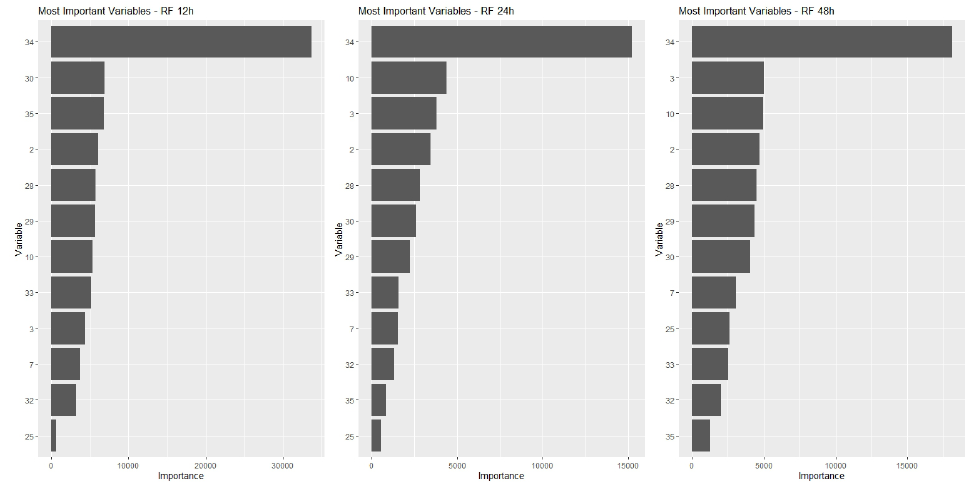
Figure 7. Most Important Variables for RF—Random Forest